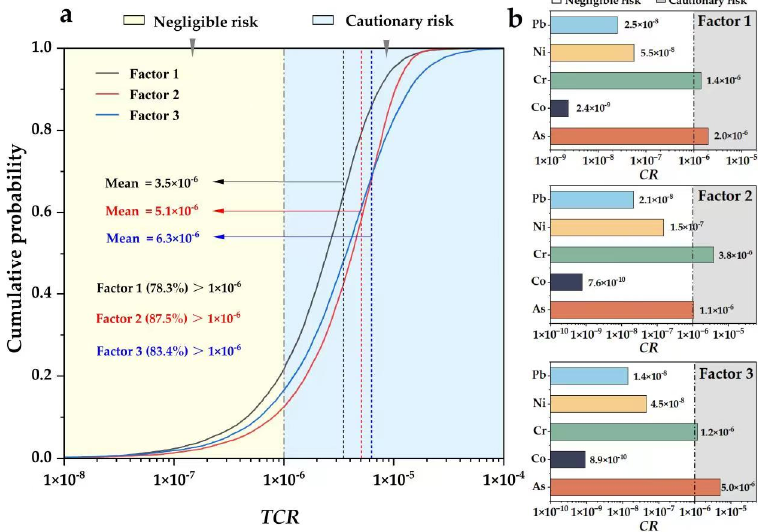
Figure 5. Probabilistic cancer risk of source-specific for children. ( a ) Cumulative probability of TCR of source-specific; ( b ) the cancer risk of each carcinogenic HM from various sources.